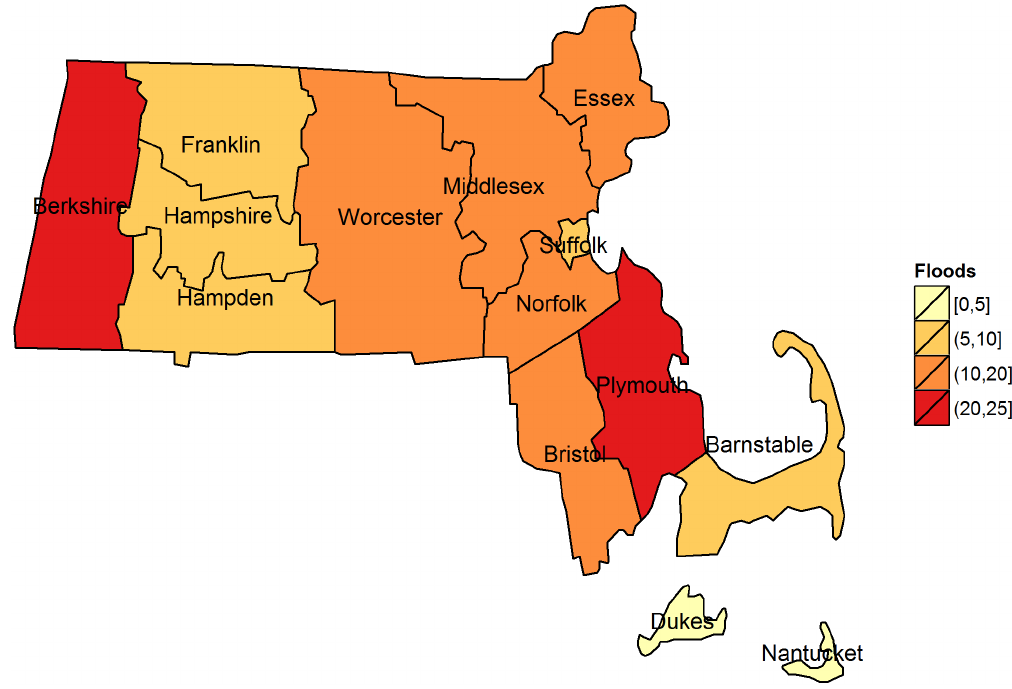
Figure 1. Number of Floods in Massachusetts by county, 2003–2007.